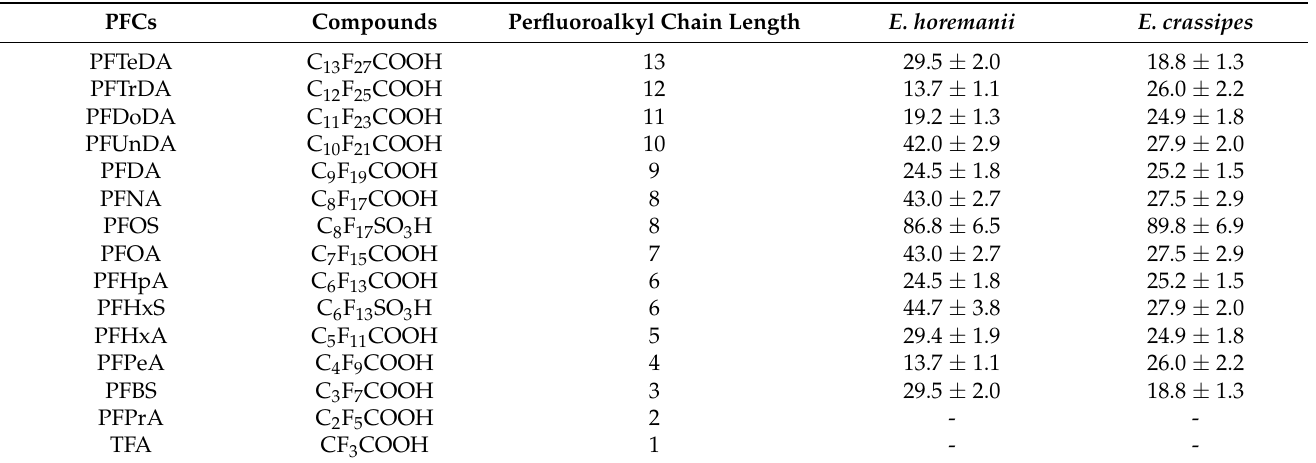
Table 4. BCFss (L/kg) of PFCs in leaf, roots, and whole-plant of E. horemanii and E. crassipes . Reprinted with permission from Ref. [91]. 2022, Pi, N.; Ng, J.Z.; Kelly,